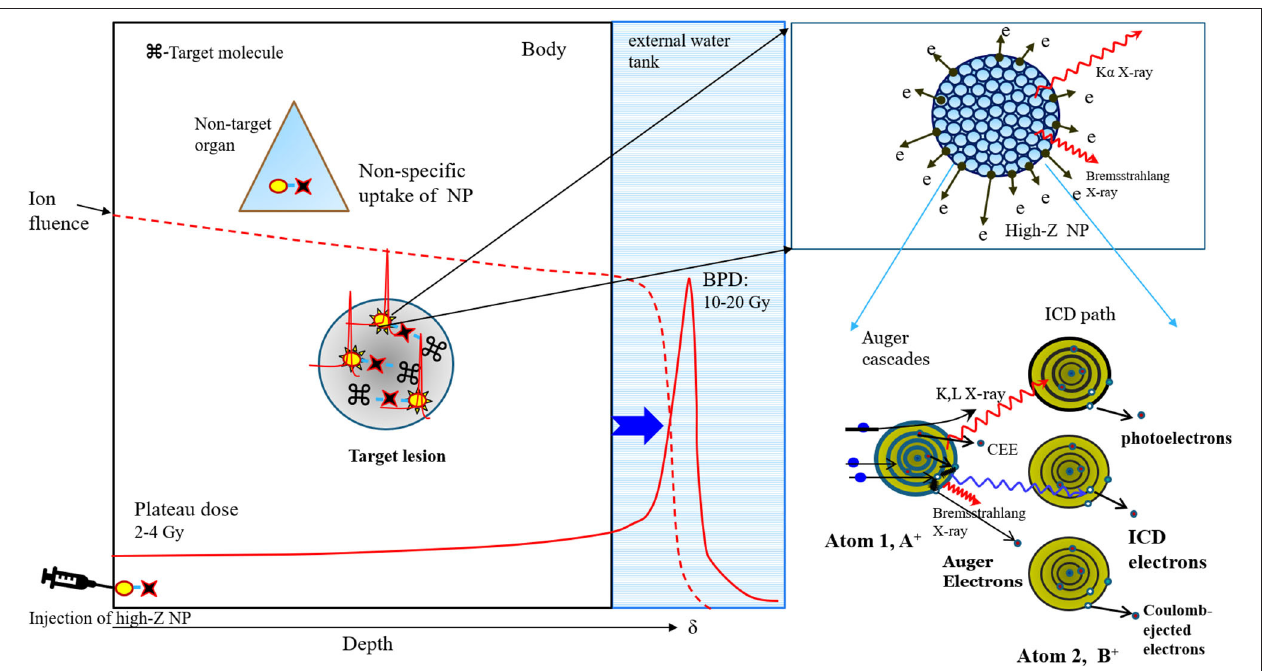
FIGURE 1 | Schematic diagram of low-energy electrons (LEEs) and characteristic X-ray fluorescence (XFL) emission from proton-stimulated high-Z nanoparticles in target tissue via Auger cascades and the interatomic Coulomb decay path (right panel). The proton fluence during the traversal of tissues (result of simulation, 2) containing target lesions with nanoparticles abruptly decays to zero at the Bragg peak position, resulting in the deposition of all energy, but the plateau dose is absorbed by the tissue along the beam path, resulting in the stimulation of nanoparticles with a dose comparable to BPD (left